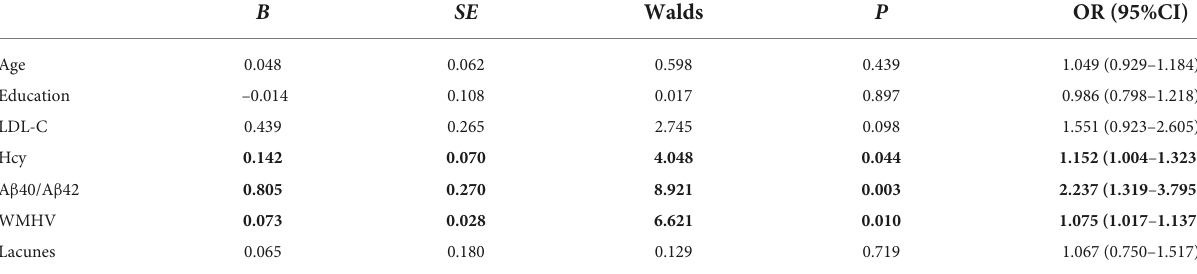
TABLE 2 The results of the binary logistic regression analysis of clinical risk factors for cognitive impairment in SIVD-MCI